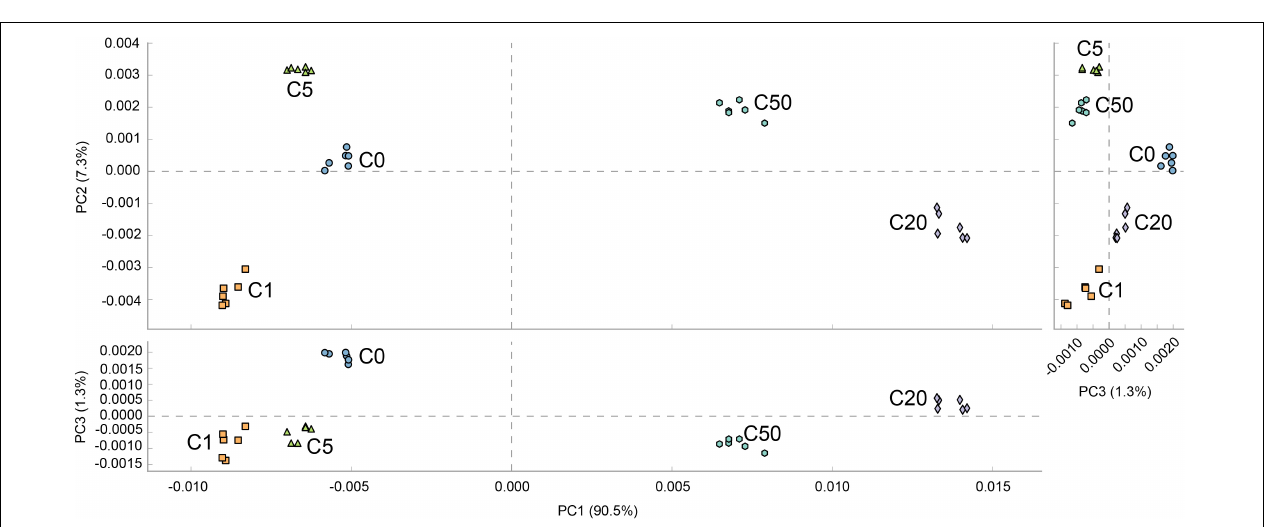
Frontiers in Microbiology |